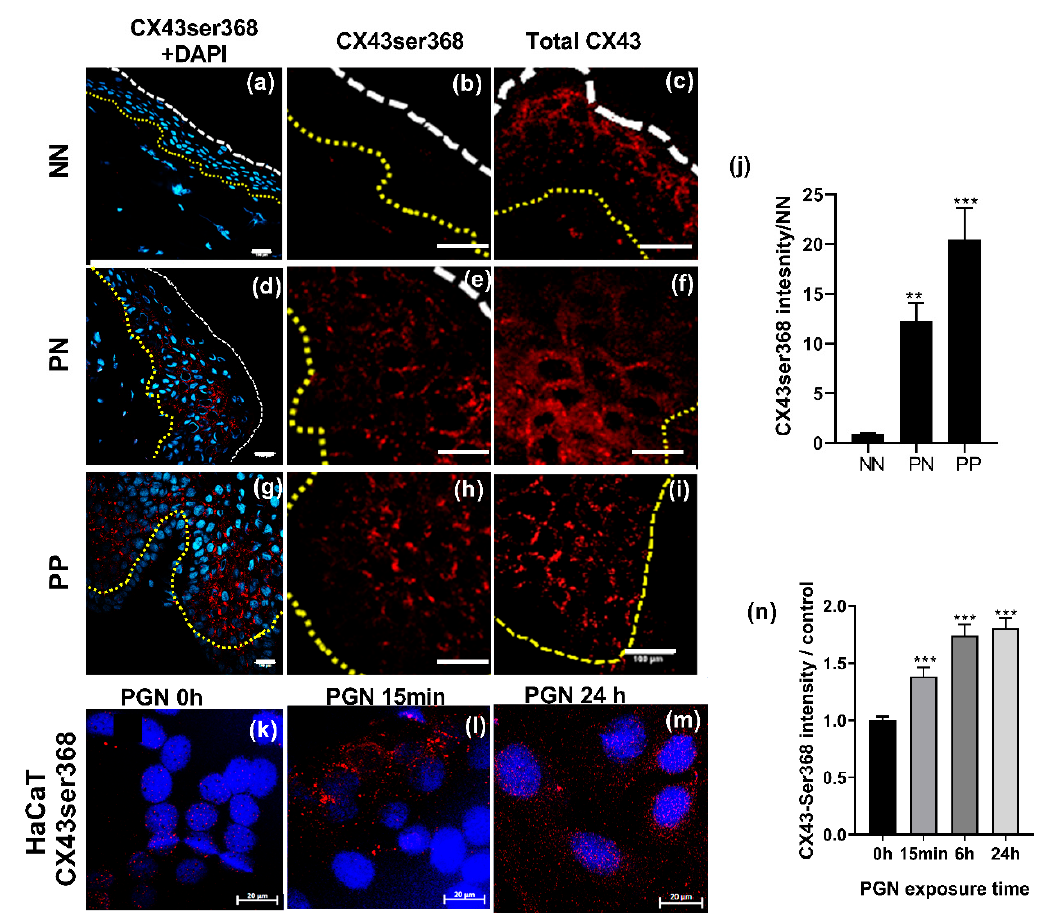
Figure 4. CX43 is post-translationally phosphorylated in psoriatic tissue and following the PGN challenge of keratinocytes. Frozen sections of biopsies were sectioned and stained with an antibody targeted to phosphorylated CX43ser368 (red and DAPI blue) or an antibody targeting total CX43. Representative images of NN ( a – c ); PN ( d – f ) and; PP ( g – i ) are presented. Bar = 100 µ m; ( j ) The fold increase in mean fluorescent intensity (MFI) extracted from multiple images of CX43ser368 staining of PN and PP biopsies over NN is represented ( N = 4 donors). HaCaT cells were exposed to 10 µ g/mL PGN for 15 min to 24 h followed by fixation and staining for CX43ser368 ( k – m ) bar = 20 µ m. The MFI extracted from multiple images of CX43ser368 staining in PGN treated samples/control is represented in ( n ) ( N = 3). Data were statistically analysed by one-way ANOVA followed by Dunnet’s multiple comparison analysis against relevant control (NN or 0 h) ** p < 0.005; *** p <